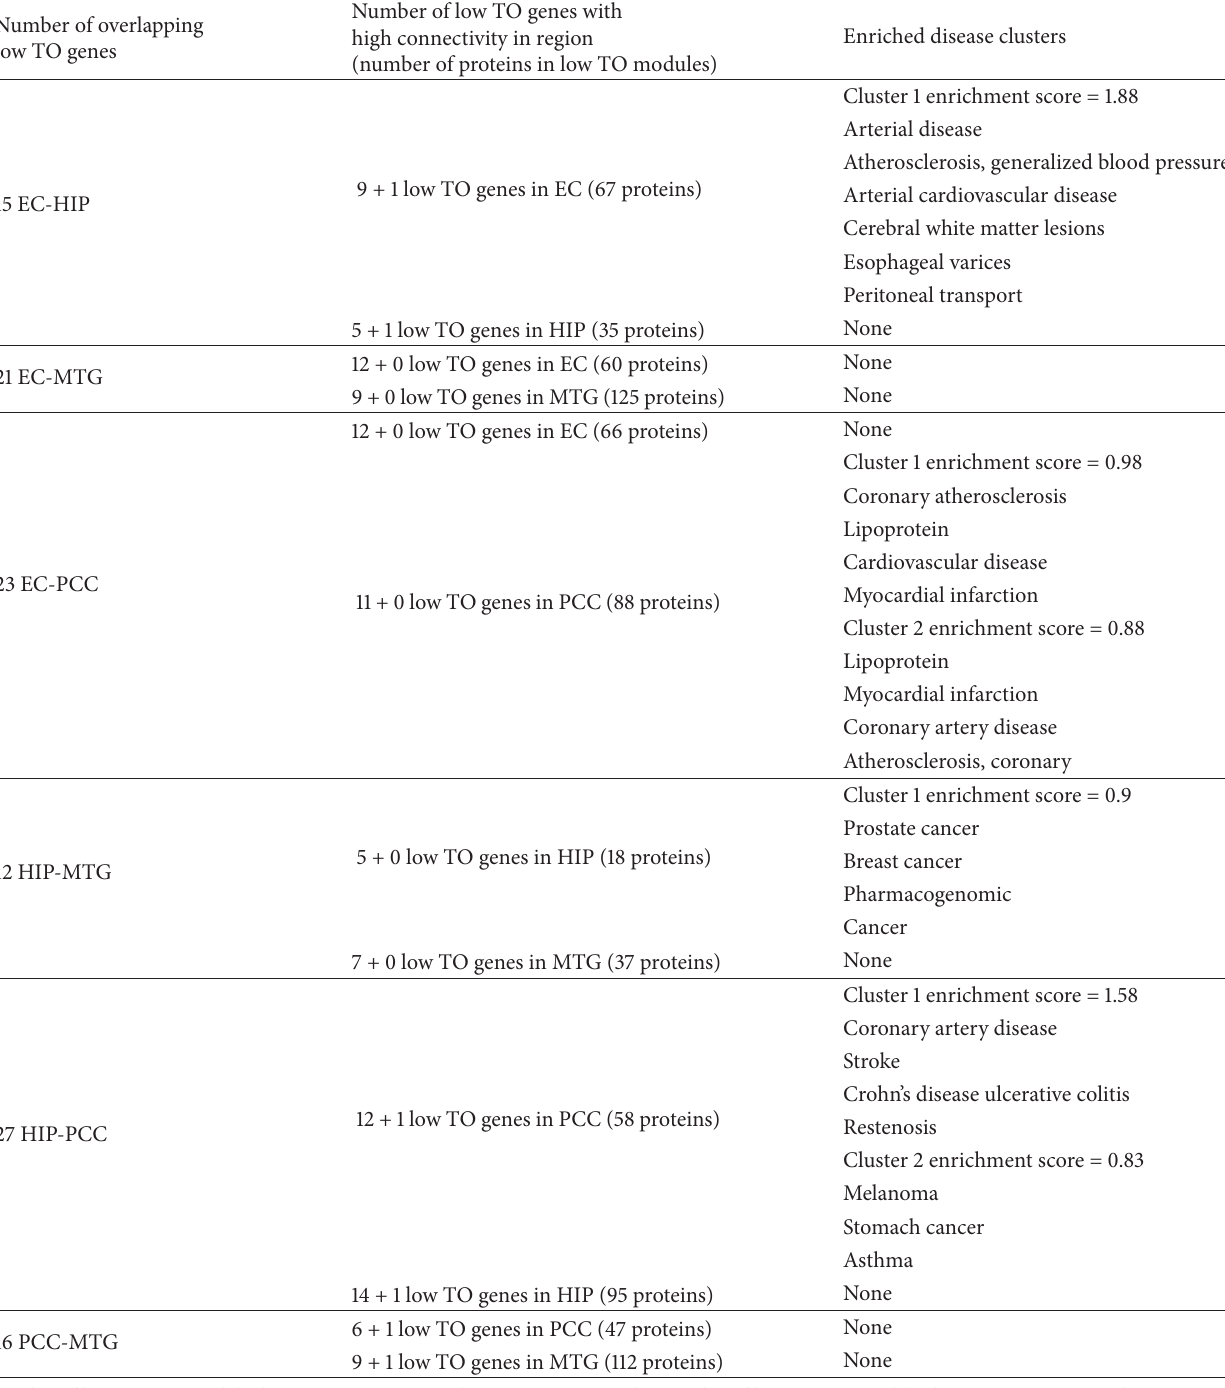
Table 6: Disease association of the pairs of low TO gene modules in Soler-L´opez et al.’s AD PPI network. Number of